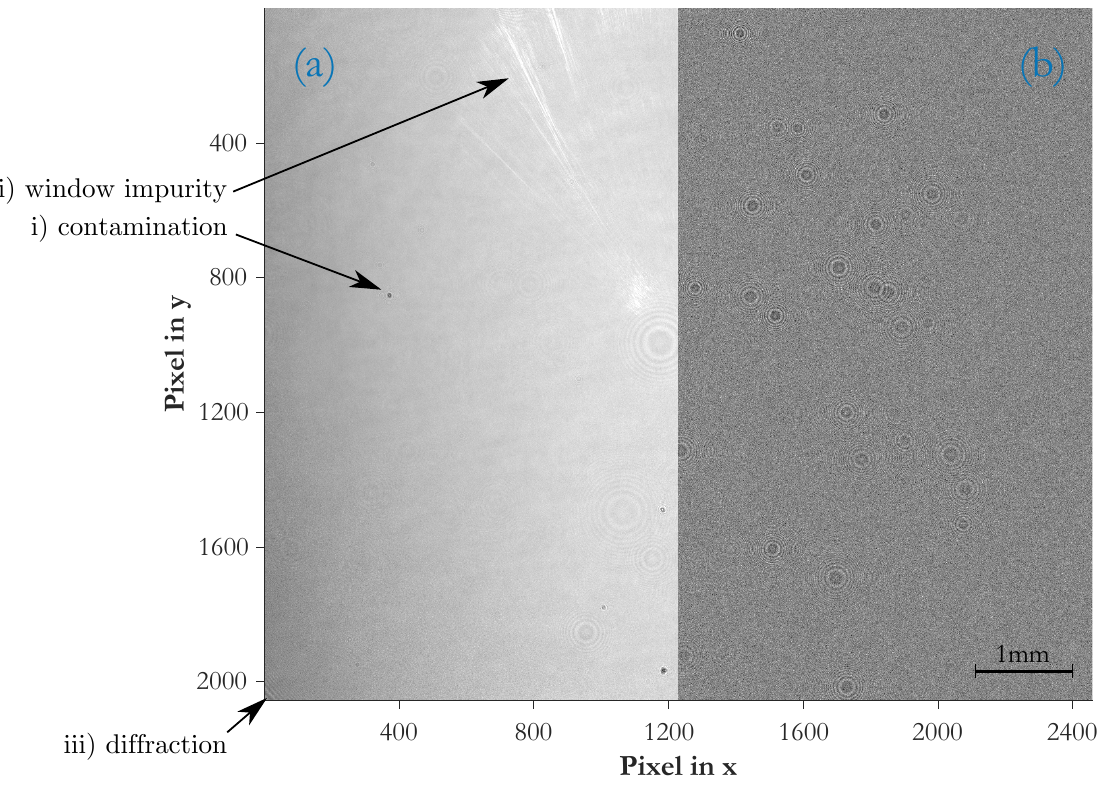
Figure 6. Imaged Hologram Plane: ( a ) left half of sampled volume as raw image. ( b ) right half of sampled volume as background corrected